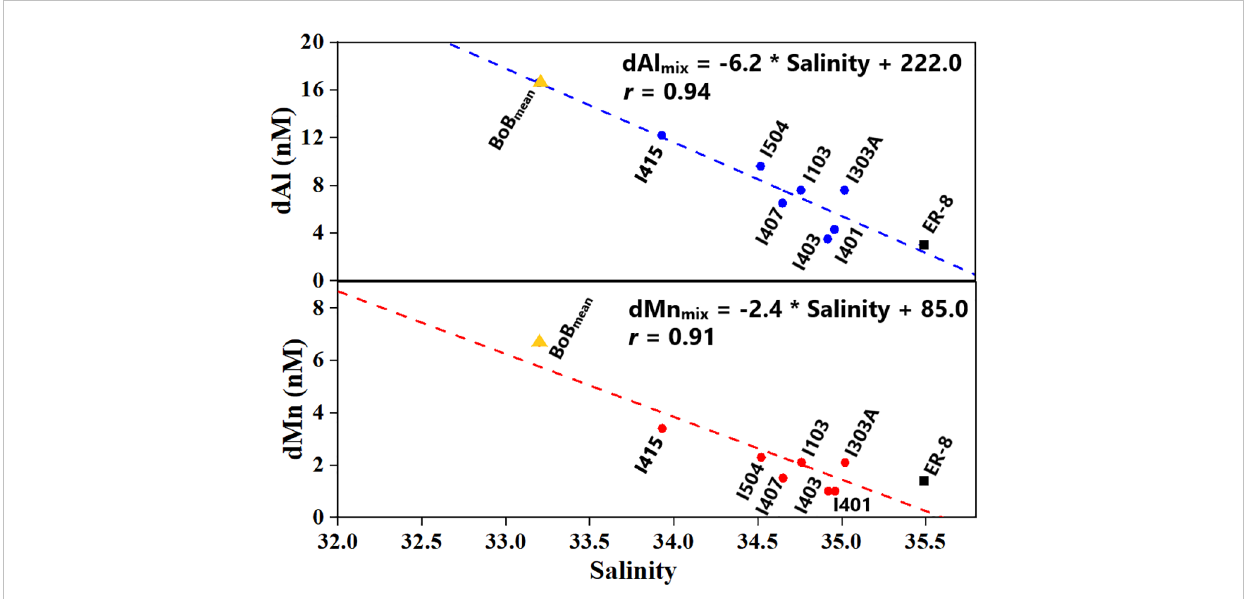
FIGURE 8 dAl (up) and dMn (down) variations with salinity for the mixed layer of stations in the Eq. IO (all stations located in 5°S – 5°N). Data point for BoB mean was the average value in the mixed layer of south BoB. Data point for station ER-8 (4.02°N, 69.00°W, Thi Dieu Vu and Sohrin, 2013) in the